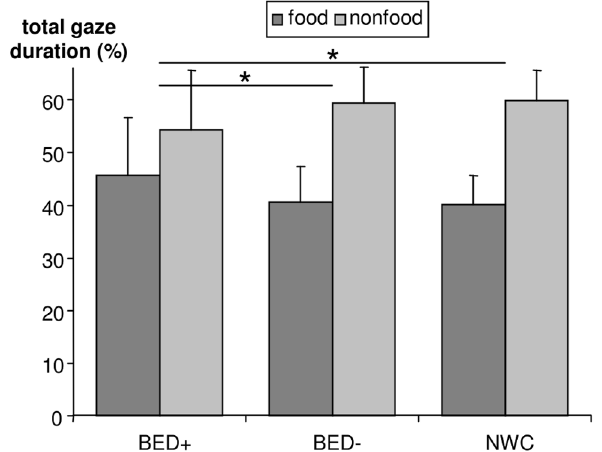
Figure 2. The percentage of total gaze duration on food vs. nonfood stimuli. Figures showing means and standard deviations.